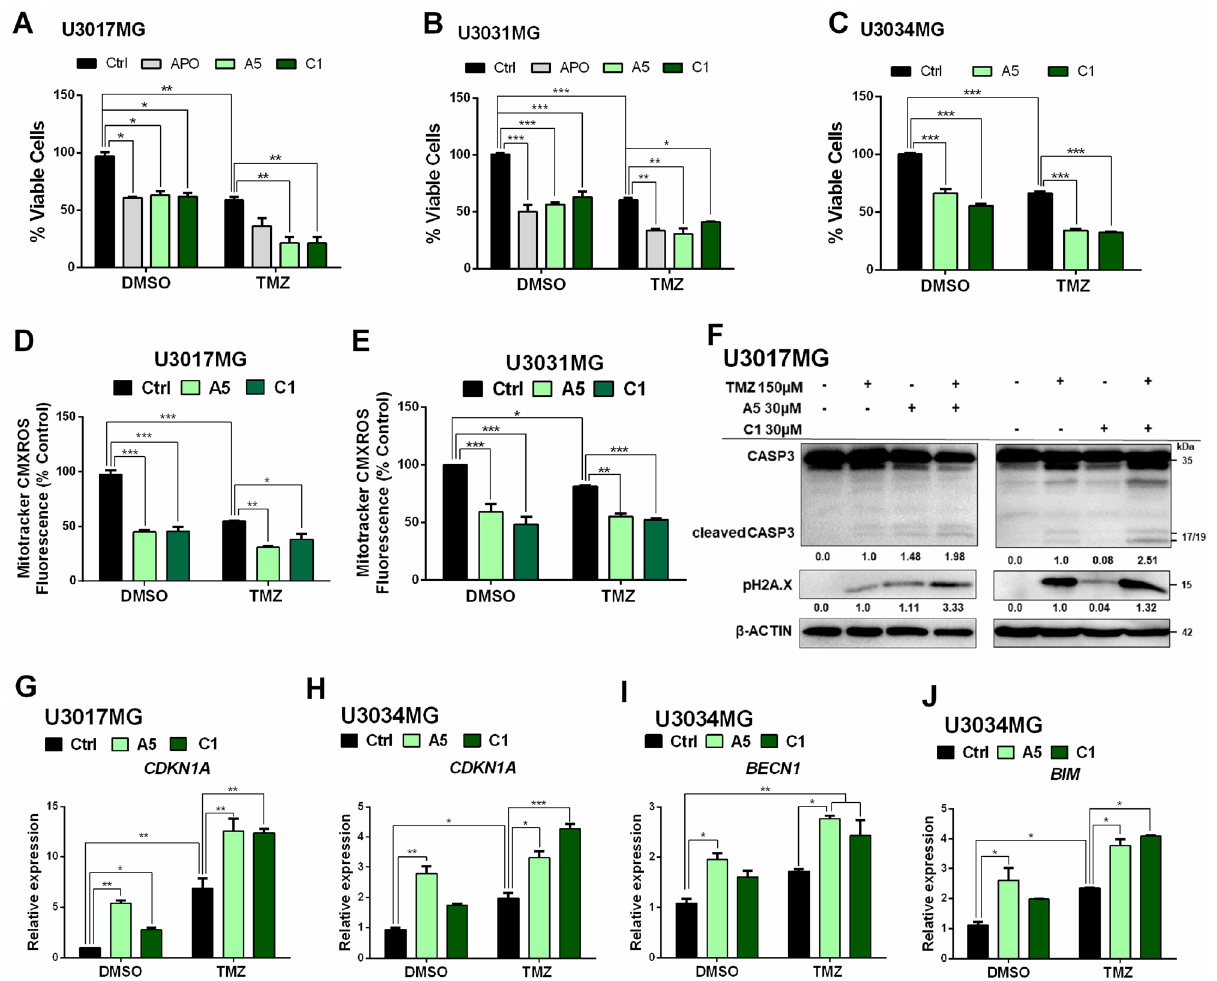
of cleaved caspase-3 and pH2A.X in U3017MG cells treated with A5 or C1 combined or not with TMZ for 48 h. β-Actin was used as loading control and molecular mass (kDa) markers are indicated along with densitometric values of normalized band intensity. The grouping of blots was cropped from different parts of the same gel. RT-qPCR was used for detection of ( G , H ) CDKN1A mRNA levels in ( G ) U3017MG and ( H ) U3034MG cells treated with A5 or C1 combined or not with TMZ for 48 h. ( I , J ) RT-qPCR was used for detection of ( I ) BECN1 and ( J ) BIM in U3034MG cells treated with A5 or C1 combined or not with TMZ for 48 h. All the relative expression levels were normalized to GAPDH expression and calculated using the 2 −ΔΔCt method. Error bars represent SD from three biological replicates and p values were calculated according to the two-way ANOVA test followed by Bonferroni (post-test); * p < 0.05, ** p < 0.01, *** p <